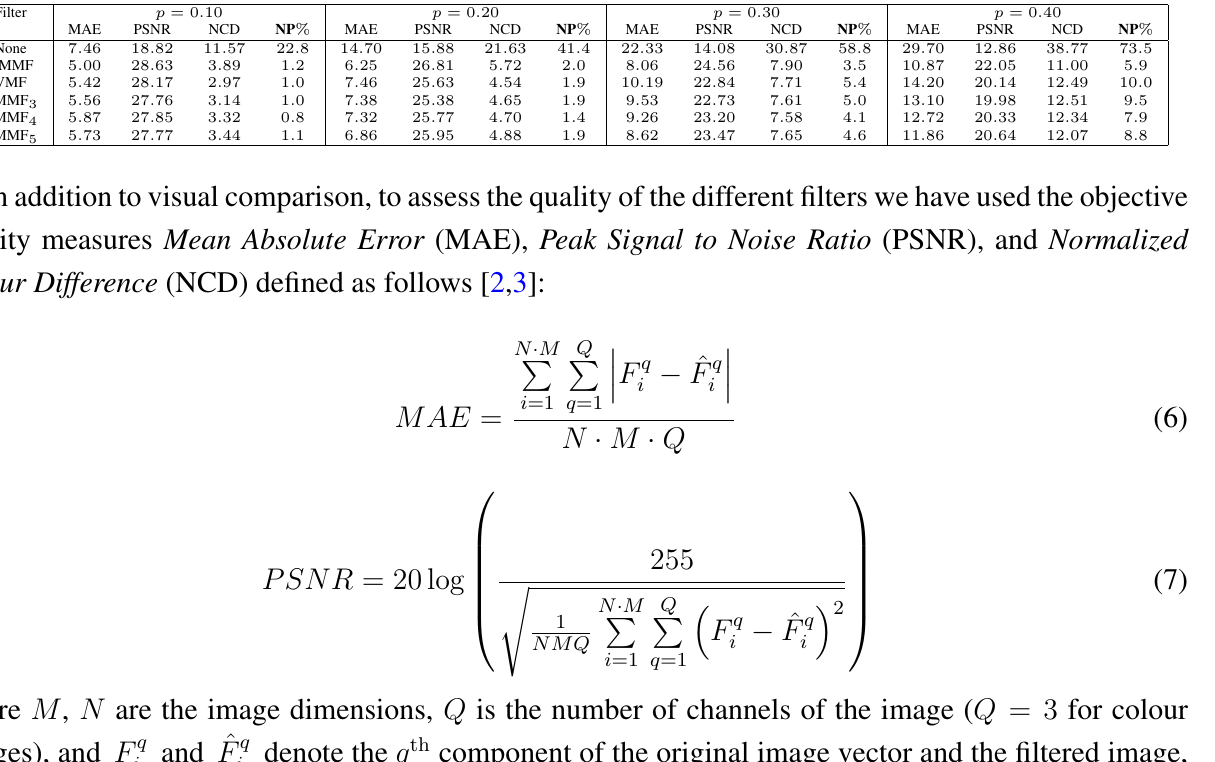
Table 4. Performance comparison in terms of MAE, PSNR, and NCD when filtering the Flower image contaminated with random-value impulse noise with probability p in each colour